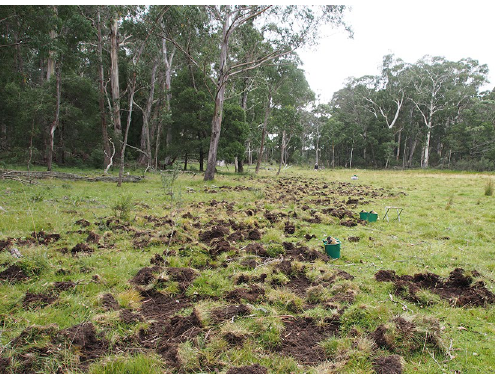
Figure 9. Nunnock Swamp Nature Reserve, NSW, where soil samples were obtained for Phytophthora testing from holes dug by pigs. The exposed clumps of soil allowed easy collection of replicated samples on boots using a protocol similar to the one used in the greenhouse